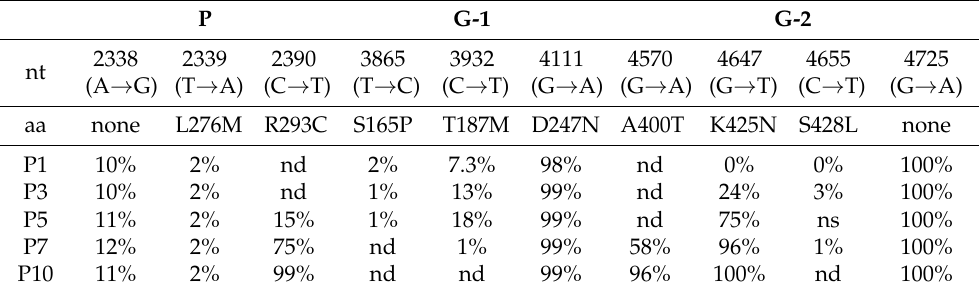
Table 3. Single nucleotide variants detected by amplicon sequencing of rRABV DogB-P1after 1, 3, 5, 7, and 10 passages on BHK cells. The frequencies of the identified variants are indicated for every passage number. nd: not detected (variant below 1% cutoff). ns: not sequenced. nt: